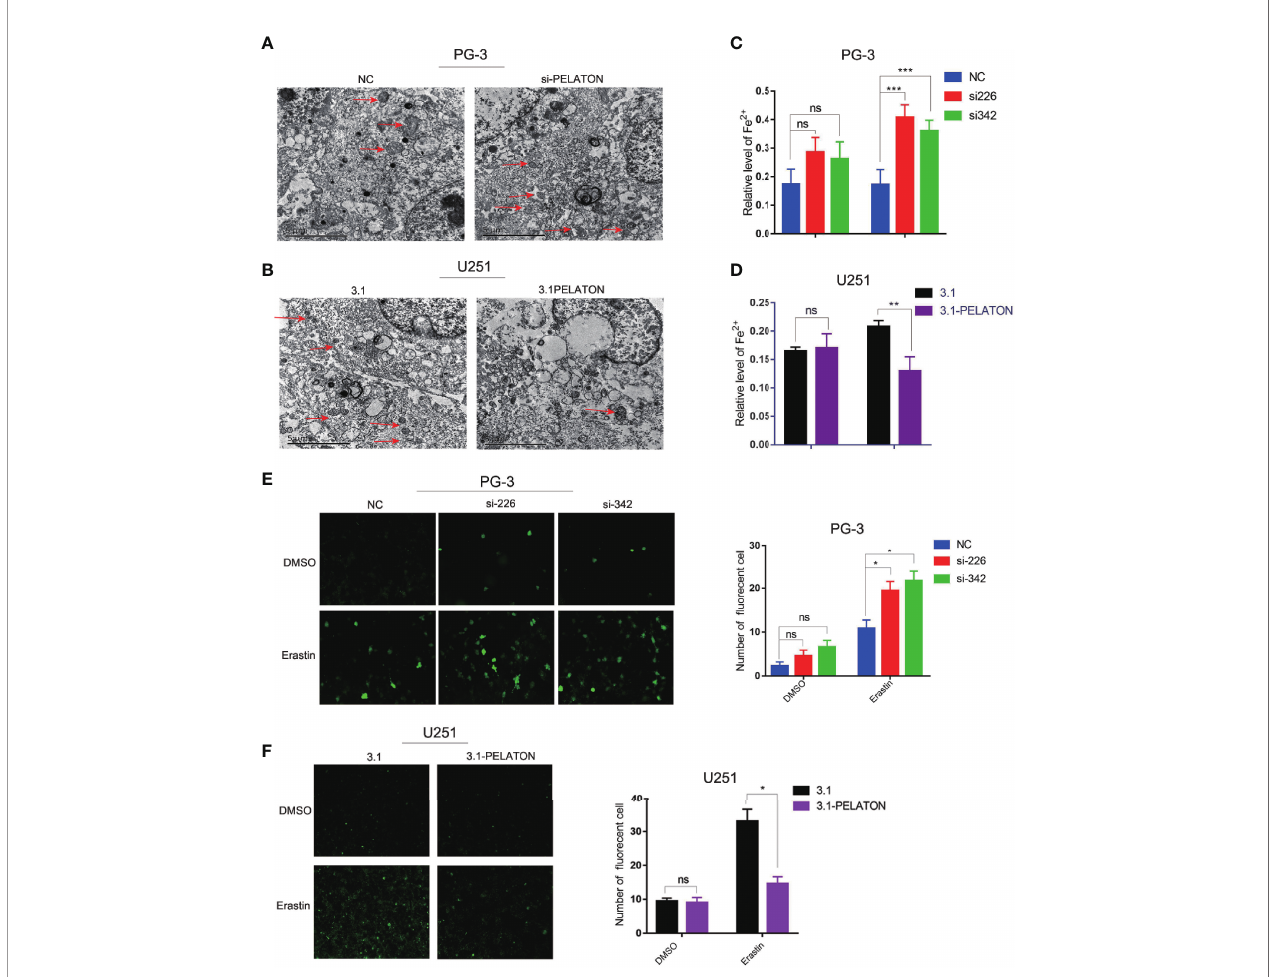
FIGURE 4 | PELATON is a novel ferroptosis suppressor in GBM. The effect of downregulation (A) or upregulation (B) of PELATON on the morphology of mitochondria in glioblastoma cells assayed by transmission electron microscopy, independent experiment was repeated for three times. The effect of downregulation (C) or upregulation (D) of PELATON on the levels of iron in glioblastoma cells (**p < 0.01; ***p < 0.001; ns: not signi fi cant), Datas were mean ± SEM for three independent experiments. The effect of downregulation (E) or upregulation (F) of PELATON on the levels of reactive oxygen species in glioblastoma cells (*p < 0.05; ns, not signi fi cant), Datas were mean ± SEM for three independent experiments. Fluorescence intensity of the active oxygen probe photographed by laser confocal microscopy (left) and quanti fi cation of the fl uorescence intensity of the reactive oxygen species probe